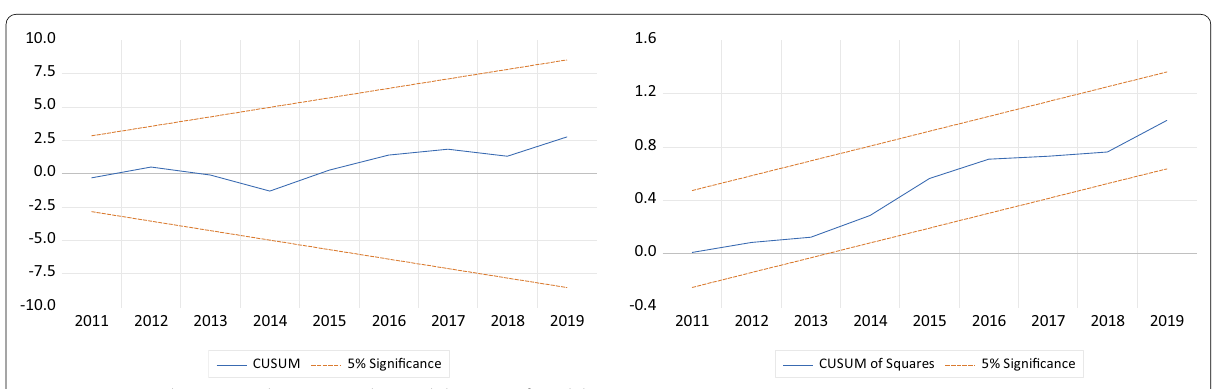
Fig. 6 CUSUM and CUSUMSQ long-run analysis stability tests of model